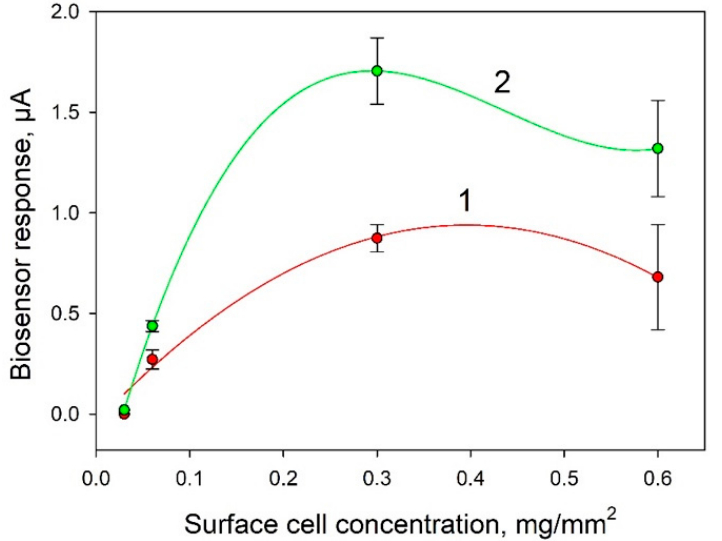
Figure 5. Dependence of the biosensor signal on the introduction of 0.3 mM (1) and 1 mM (2) glucose on the concentration of bacterial cells on the surface of an electrode modified with PEDOT:PSS and graphene.